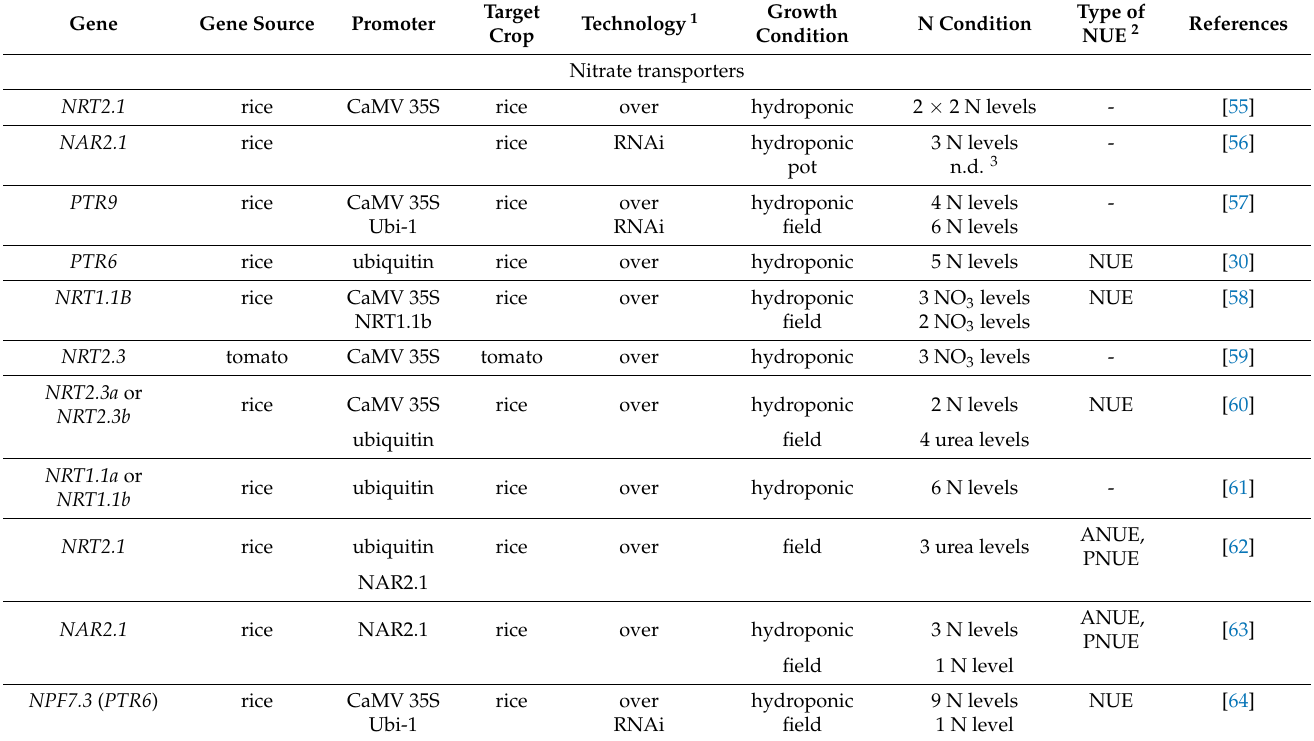
Table 1. Manipulation of nitrogen uptake genes to improve nitrogen use efficiency in crops. Gene Gene